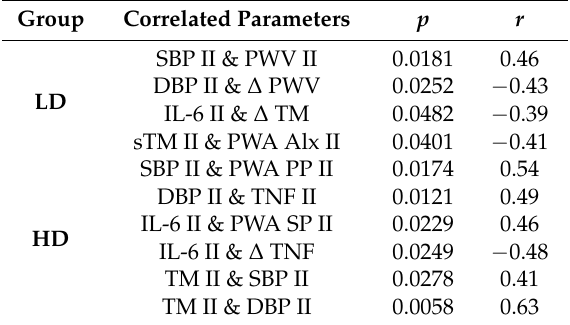
Table 5. The significant correlations in the high dose (HD) and low dose (LD)